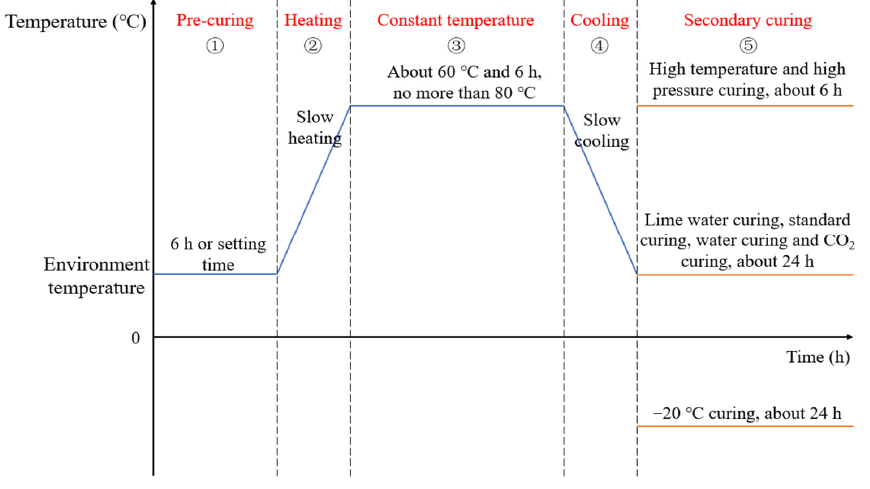
Figure 10. The curing regimes of PC.